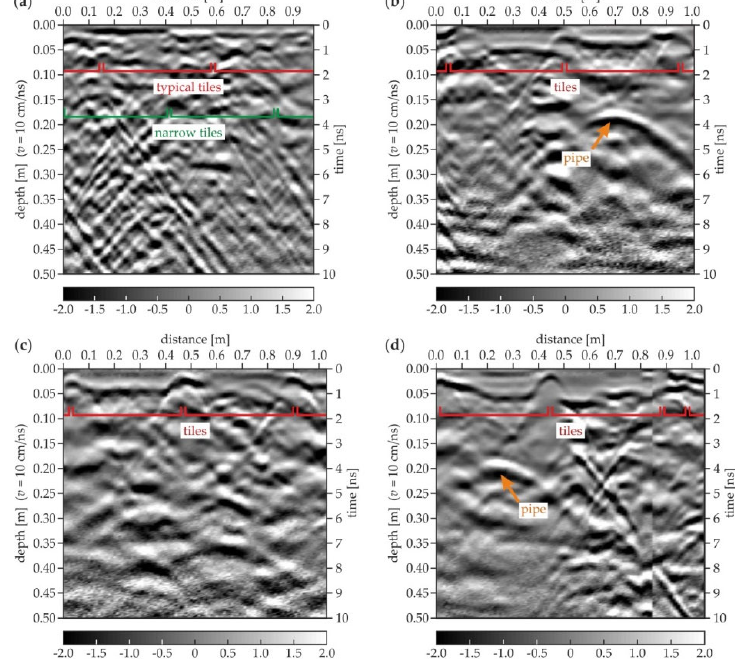
Figure 15. GPR B ‐ scans for the trial pit: ( a ) edge 1 (trace C ‐ 1); ( b ) edge 2 (trace C ‐ 2); ( c ) edge 3 (trace C ‐ 3); ( d ) edge 4 (trace C ‐